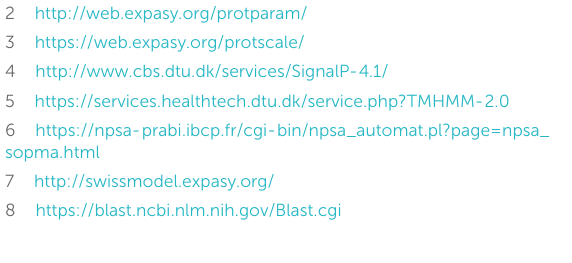
Figure 3 summarized the kinetics of cell growth, sugar consumption, and CDA activity during the fermentation processes of B. aryabhattai TCI-16. As shown in Figure 3 , B. aryabhattai TCI-16 entered the logarithmic growth